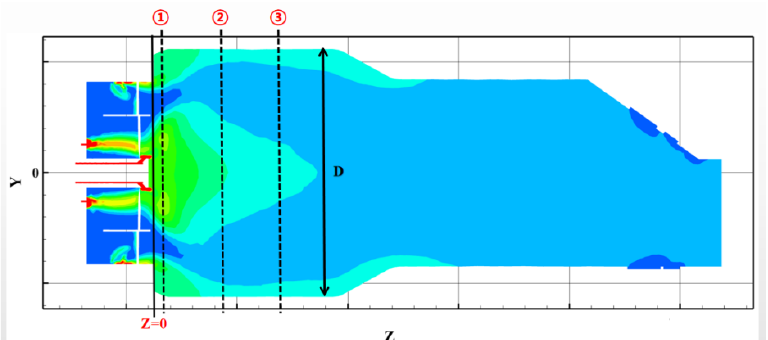
Figure 6. The selected monitoring plane position in the combustor. Colors represent different flow velocities.